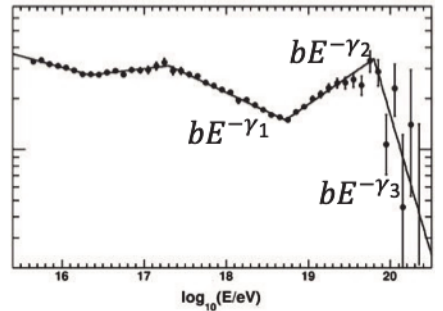
Figure 1: The energy spectrum obtained from the TA experiment[7]